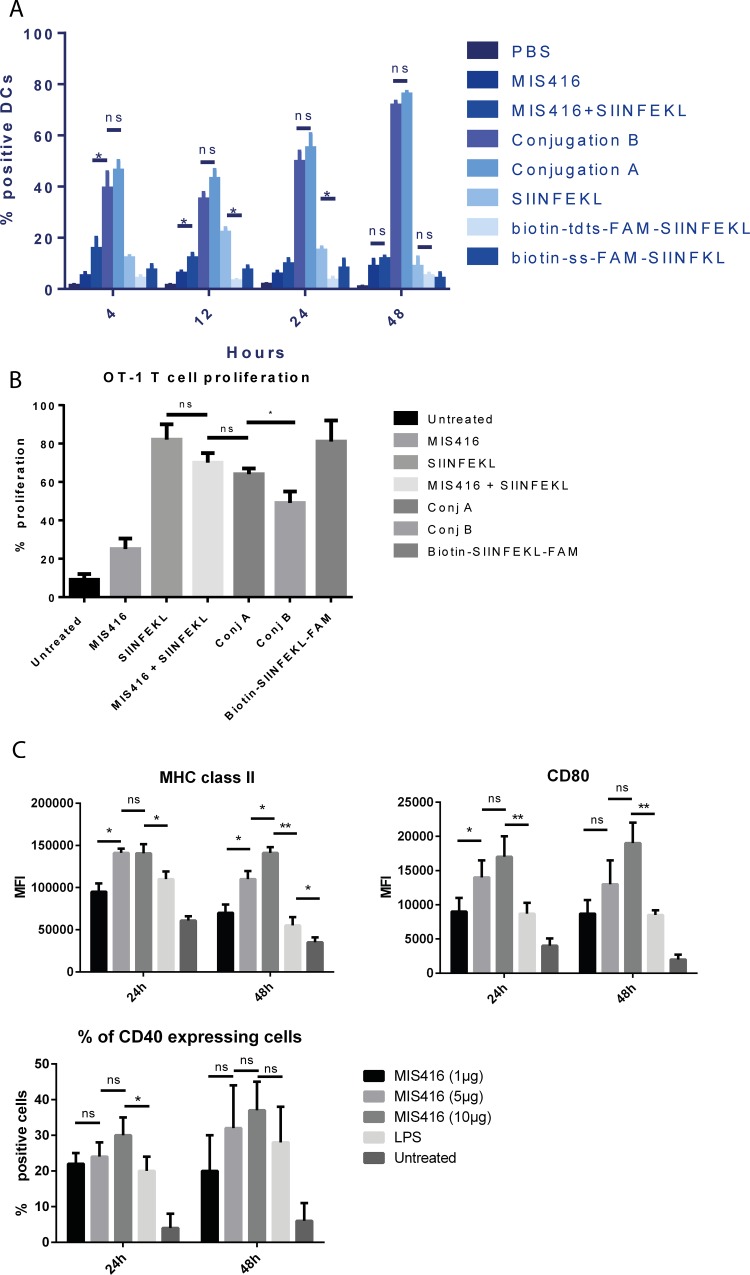
Conjugate A (containing a disulfide bond) behaved similarly to conjugate B (lacking a disulfide bond) with respect to in vitro presentation of SIINFEKL on MHC class I molecules on BMDCs, but performed better than conjugate B in in vitro T-cell proliferation assays A) BMDCs were treated in vitro for 4, 12, 24 and 48h with conjugates of MIS416 and controls, as indicated.BMDCs treated with PBS or MIS416 alone were used to set background fluorescence, and as a negative control. Cells were pre-gated on live cells and positive staining with CD11c. The treatment of BMDCs with SIINFEKL alone, or with a mixture of MIS416 plus SIINFEKL (unconjugated), or biotinylated SIINFEKL (biotin-SS-FAM-SIINFEKL, or biotin-tdts-FAM-SIINFEKL) resulted in approximately 22% of BMDCs presenting SIINFEKL antigen in MHC class I molecules. In contrast, conjugates A and B, containing a disulfide bond (conjugate A), or lacking a disulfide bond (conjugate B), were more efficient at processing and presenting SIINFEKL antigen in MHC class I molecules on BMDCs. Conjugate A behaved in a similar fashion to conjugate B. *, p<0.05. Error bars represent SEM. tdts = 1,13-diamino-4, 7, 10-trioxatridecan-succinic acid. B) DCs (1x106 in 2 mL of media) were treated with LPS (1 μg) and MIS416 (1, 5, 10 μg). Cells were collected and stained in live/dead assays (0.05 μL plus 100 μL of PBS for each sample) and with different antibodies to detect activation markers (CD40, CD80, MHC class II) and DCs (CD11c). Y axis represents the Mean Fluorescence Intensity (MFI). For CD40 the % of positive cells for CD40 was used instead of MFI. C) OT-1 T cell proliferation assays carried out to determine the percentage of proliferating T-cells following exposure to BMDCs. BMDCs were treated with MIS416, SIINFEKL, MIS416 + SIINFEKL, conjugates A and B and biotin-SIINFEKL-FAM for 24h. Untreated cells were used as negative control. After 24 h, OT-1 T-cells were co-cultured with the treated BMDCs for 72h. The percentage of T-cells proliferating for each sample was calculated using FlowJo (V9) flow cytometry data analysis software. The results represent the combined analysis of 5 separate OT-1 T-cell prolideration assays. Error bars represent SEM. Results that are not significant are marked with ns while significant results are marked with * depending on the P values (* P < 0.05, ** P < 0.005, *** P < 0.0005). This experiment was repeated three times.